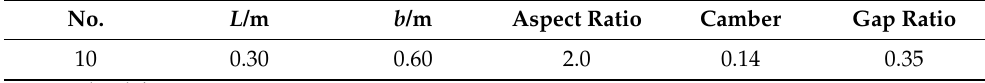
Table 7. Dimensions and structural parameters of the optimized